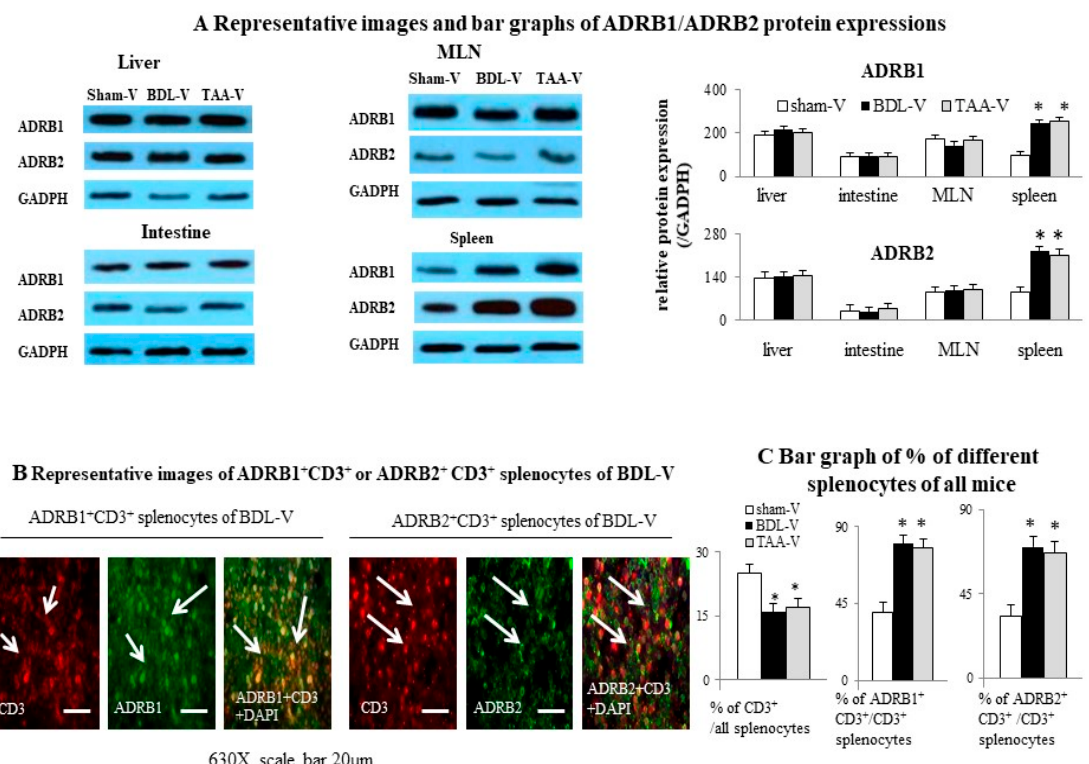
Figure 2. Over-expressions of β 1 and β 2 adrenergic receptors (ADRB1 and ADRB2) proteins were noted in spleen and splenic T lymphocytes of cirrhotic mice. ( A ) Representative images and bar graphs of ADRB1 / ADRB2 protein expressions in liver, intestines, mesenteric lymph node (MLN), and spleen in sham-V and cirrhotic (BDL-V / TAA-V) mice; ( B ) Representative immunofluorescence images of ADRB1 + CD3 + or ADRB2 + CD3 + splenocytes of BDL-V mice. White arrows represent positive of CD3, ADRB1, ADRB2, CD3 and ADRB1 or CD3 and ADRB2; ( C ) Bar graphs of percentages of CD3 + , ADRB1 + CD3 + and ADRB2 + CD3 + splenocytes of sham-V or cirrhotic (BDL-V / TAA-V) mice. * p < 0.05 vs. sham-V group.